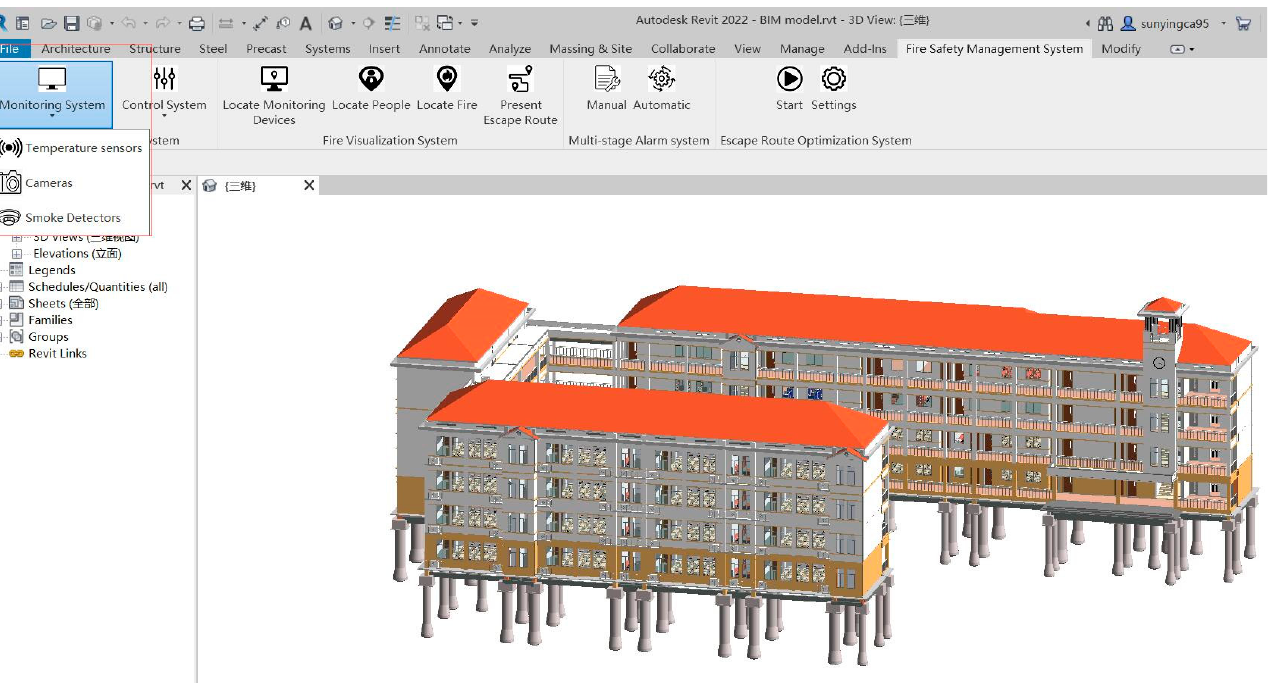
Figure 3. Example of components in the monitoring system of the remote monitoring subsystem.